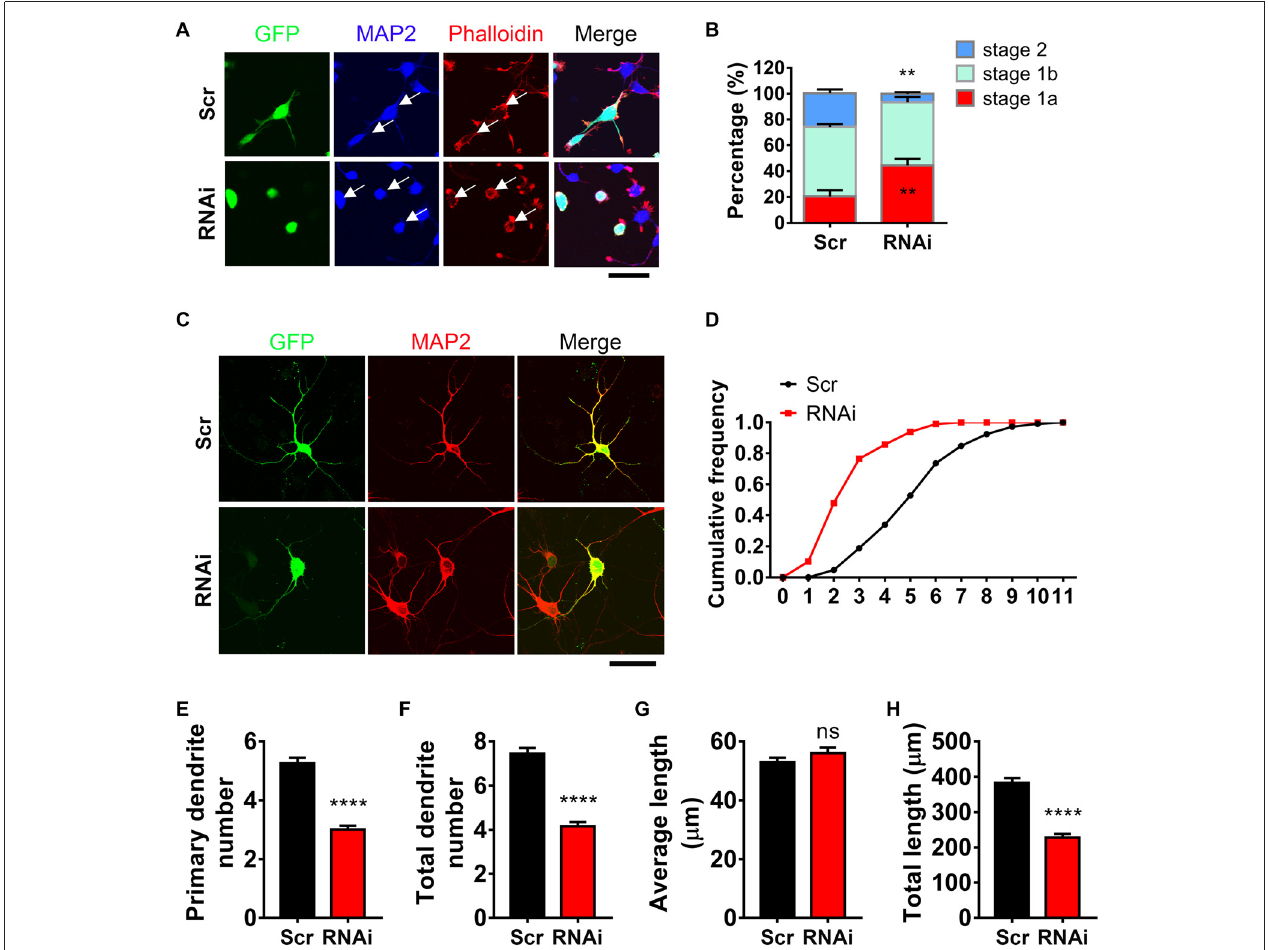
FIGURE 2 | HIP1R is necessary for inducing neurite initiation and dendritic branching. (A) Representative images of cultured neurons electroporated with Scrambled-RNAi (Scrambled) or HIP1R-RNAi. GFP (green), MAP2 (blue) and phalloidin (red). Arrows indicate GFP-positive cells expressing Scrambled-RNAi or HIP1R-RNAi. Scale bar, 20 µ m. (B) Quantification of neurite initiation ( n = 3,749 neurons for the Scrambled group and 3,045 neurons for the RNAi group). (C) Representative images of day in vitro (DIV) 5–6 cultured neurons electroporated with Scrambled-RNAi or HIP1R-RNAi. MAP2 was used to outline the dendrites. Scale bar, 20 µ m. (D) Cumulative distribution of primary dendritic number showed that HIP1R-RNAi neurons had fewer primary branches than Scrambled control. (E–H) Quantification of dendritic number and dendritic length in the Scrambled and HIP1R-RNAi groups ( n = 106 and 151 neurons from more than